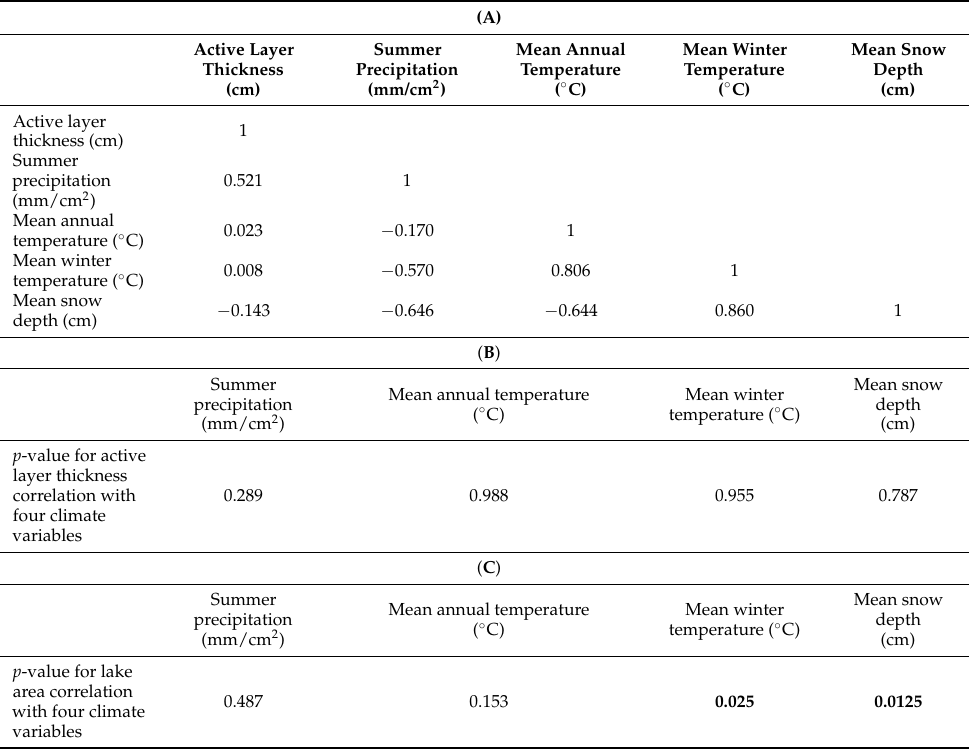
Table 3. Correlations (Pearson product–moment): among climatic factors ( A ); between active layer thickness and climatic factors ( B ); and between the area of disturbed lakes and climatic factors ( C ). Values in bold denote significant p